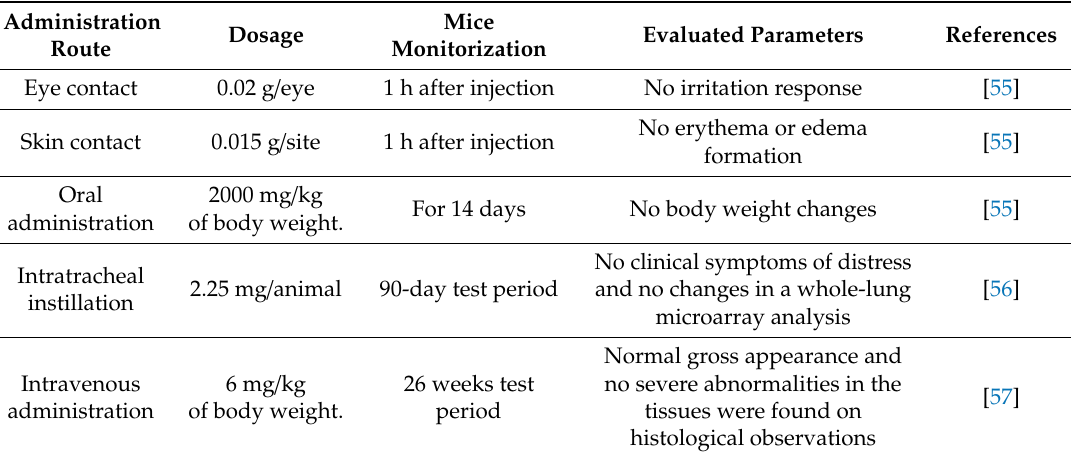
Table 1. Administration routes of